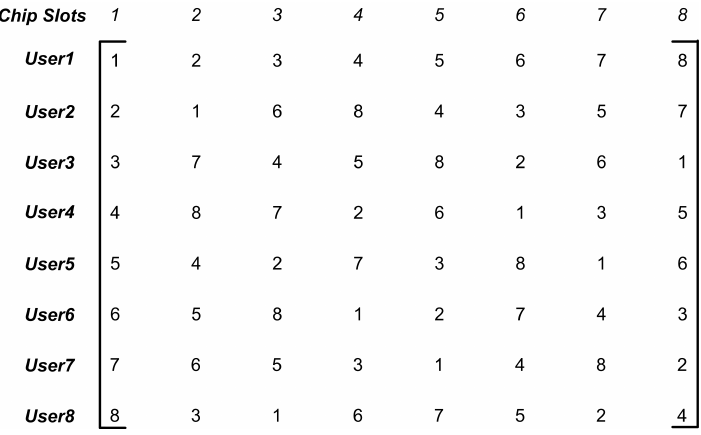
Figure 6. Wavelet Packet Indexes of segment A containing 8